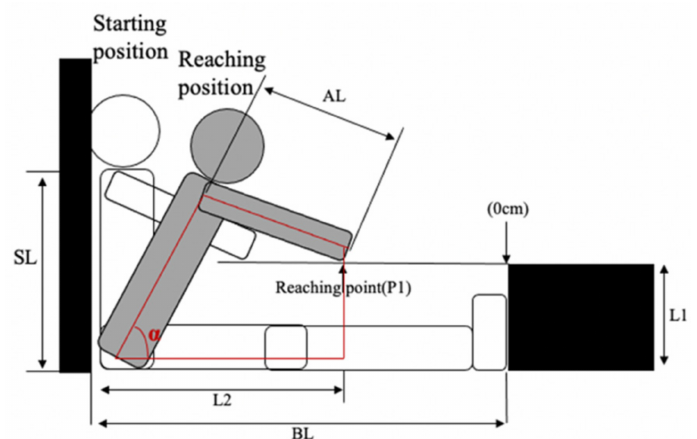
Figure 1. Illustration for MSR angle. SL, sitting height; BL, base length; AL, arm length; the height of box is 26.5 cm. An example of a 4-year-old boy: SL = 31 cm; BL = 70 cm; AL = 44 cm; P1 = − 5 cm. Then his MSR angle score is 43.07 ◦